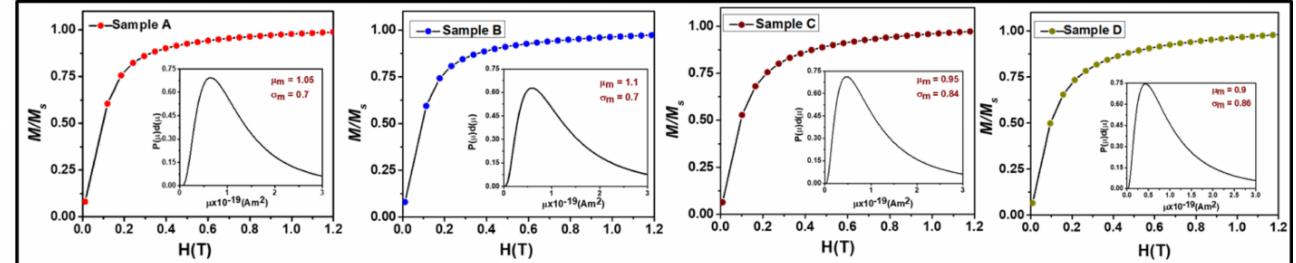
Figure 10. Langevin function fitting of the AMF samples ( A – D ) in which symbols represent the experimental data and the solid line represents the fitted curve. The insets of the figure show the permeability and standard deviation of each of the AMF